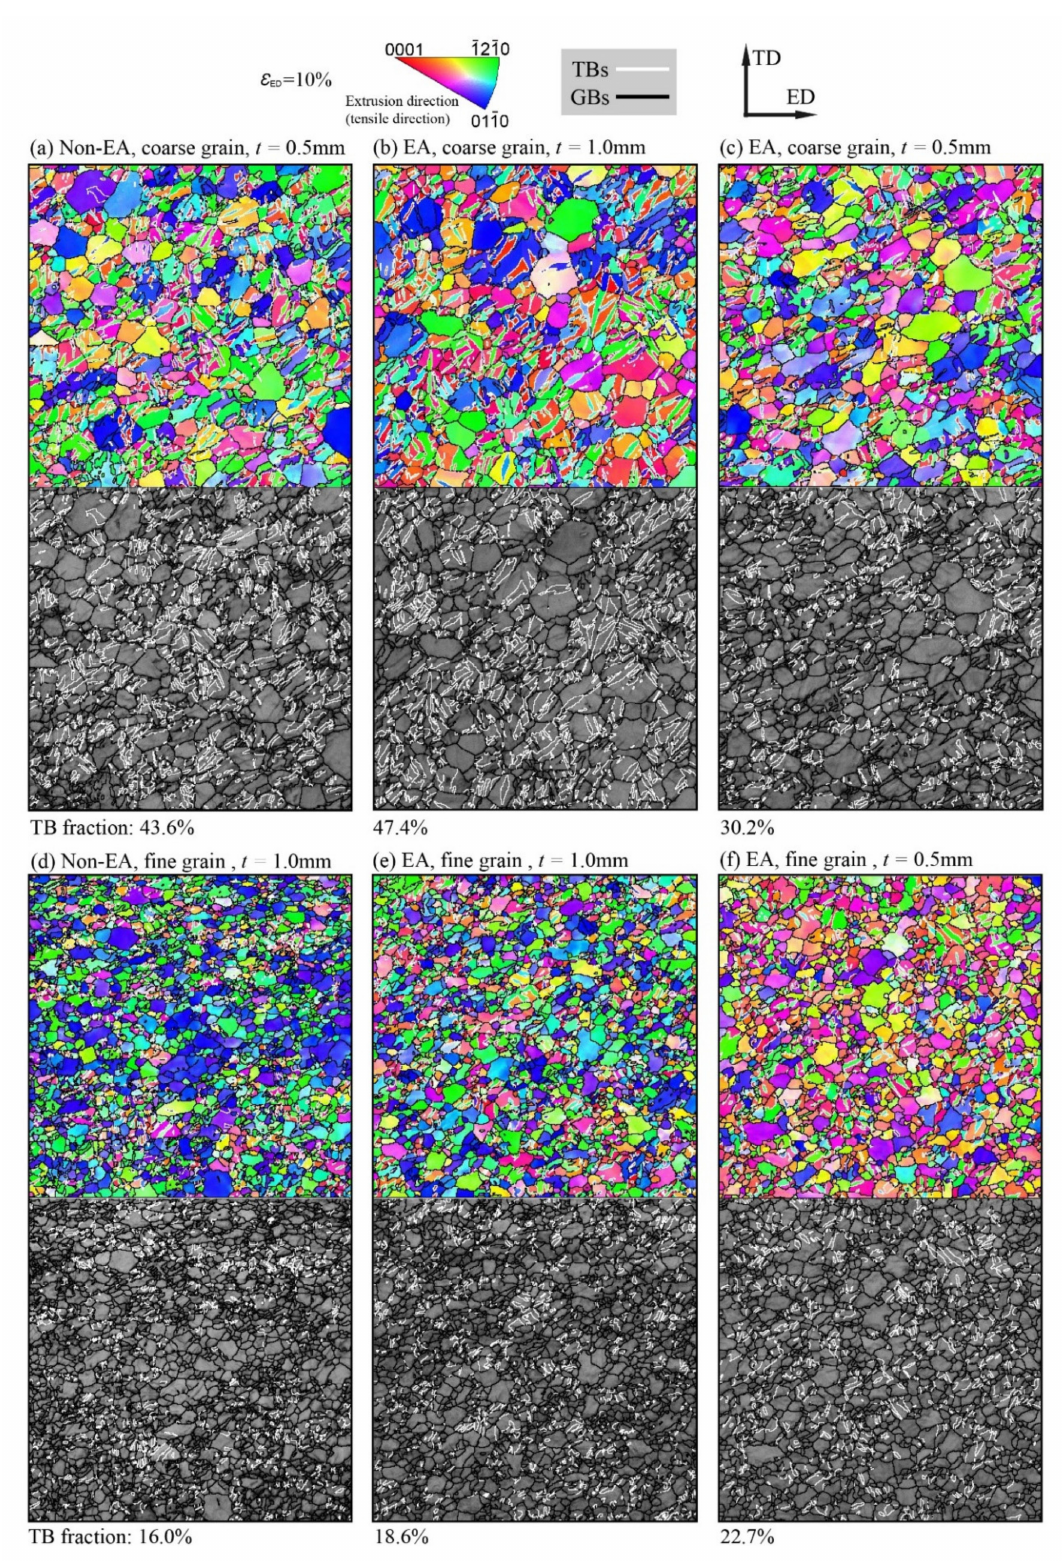
Figure 4. The orientation imaging microscopies (OIMs) and band contrast (BC) maps of the samples strained to 10% tensile deformation under various deformation conditions. ( a ) Non-EA, coarse grain, t = 0.5 mm; ( b ) EA, coarse grain, t = 0.5 mm; ( c ) EA, coarse grain, t = 1.0 mm; ( d ) non-EA, fine grain, t = 1.0 mm; ( e ) EA, fine grain, t = 1.0 mm; ( f ) EA, fine grain, t = 0.5 mm. The black lines represent grain boundaries, and the white lines represent twinning boundaries